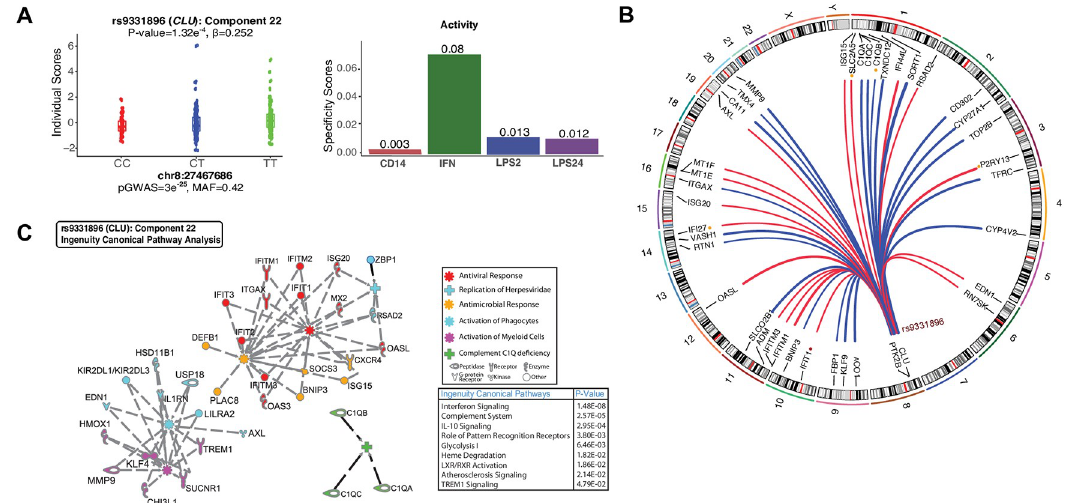
Fig 6. Trans -eQTL colocalized in Alzheimer’s disease associated CLU locus. (A) The genotypes for Alzheimer’s disease susceptibility allele rs9331896 are significantly associated with the individual scores of component 22 (left panel). The component is active in monocytes (FF) in response to interferon- γ (right panel). (B). Circular plot demonstrating the chromosomal position of trans -eSNP (rs9331896) and the 38 trans target genes. The minor and AD-protective allele rs9331896-C is associated with decreased (blue lines) and increased (red lines) expression of trans -eGenes. The colored dots are trans -eQTL that replicates in ImmVar IFN stimulated monocytes (red and yellow color dots denote trans -eQTL association at FDR < 0.05 and 0.20, respectively). Only the trans -eGenes with PIP > 0.5 and 2.5% distributional cut-off are shown. (C) IPA pathway analysis of the trans -eGenes in this component. The IPA canonical pathway enrichment P-values are shown in the lower right. The pathway network is grouped by IPA biological functions. The functional groups are defined by different colors and symbols (top